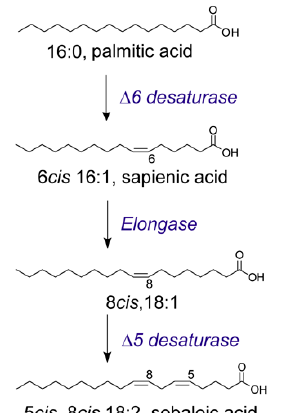
Figure 4. The metabolism of palmitic acid to sapienic acid (6cis-16:1) and its subsequent transformation to obtain the PUFA, sebaleic acid (5cis, 8cis-18:2).